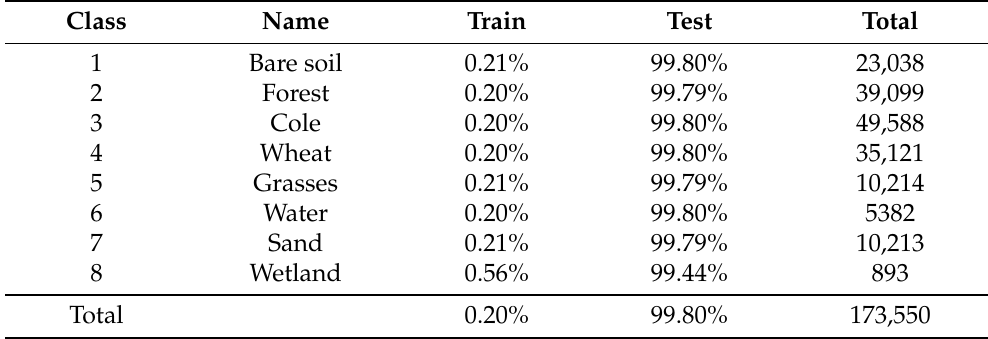
Table 5. The image information of GF-3